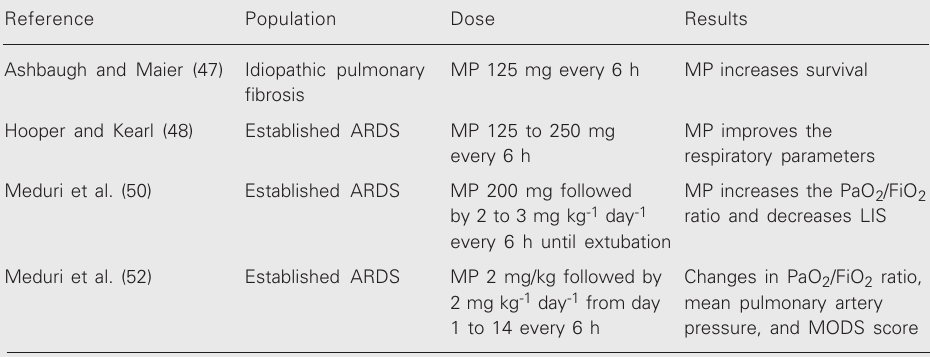
Table 2. Clinical trials of glucocorticoids in the late phase of acute respiratory distress